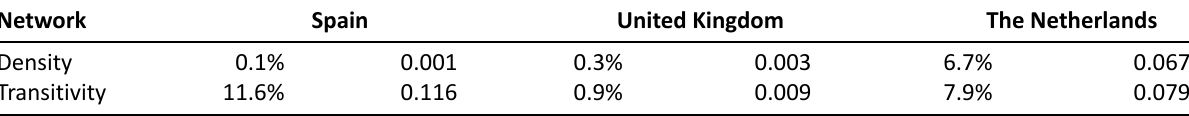
Table 3. Network cohesion, by country. Network